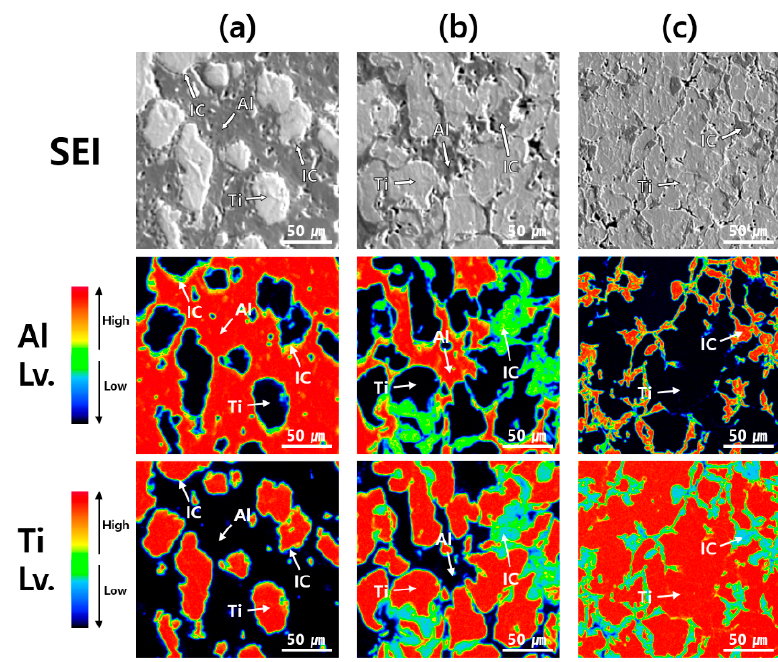
Figure 9. Field emission-electron probe microanalysis (FE-EPMA) of Al-Ti composites; SEIs and elemental maps of Al and Ti. The red regions indicate areas of high elemental content. The Al, Ti, and ICs phases are marked using white arrows. ( a ) Al-20 vol.% Ti; ( b ) Al-50 vol.% Ti and ( c ) Al-80 vol.% Ti composites.